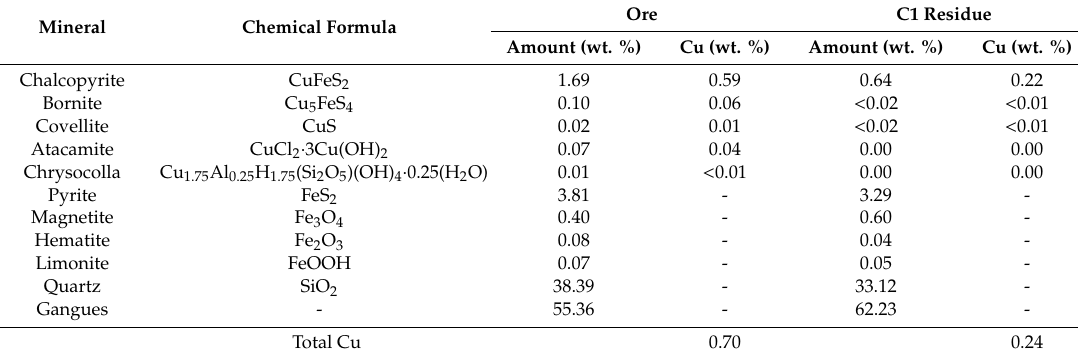
Table 9. Mineralogy of initial ore and solid residue of